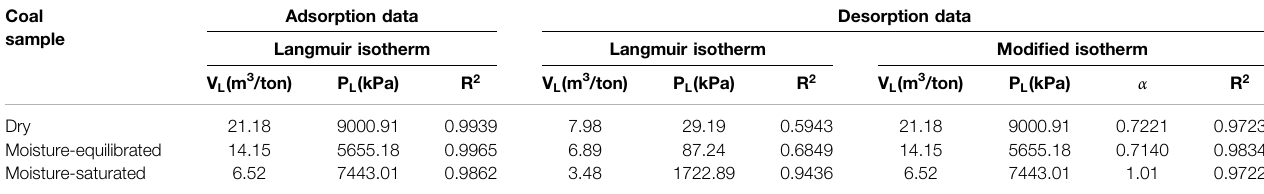
TABLE 1 | Fitting results of adsorption and desorption data.